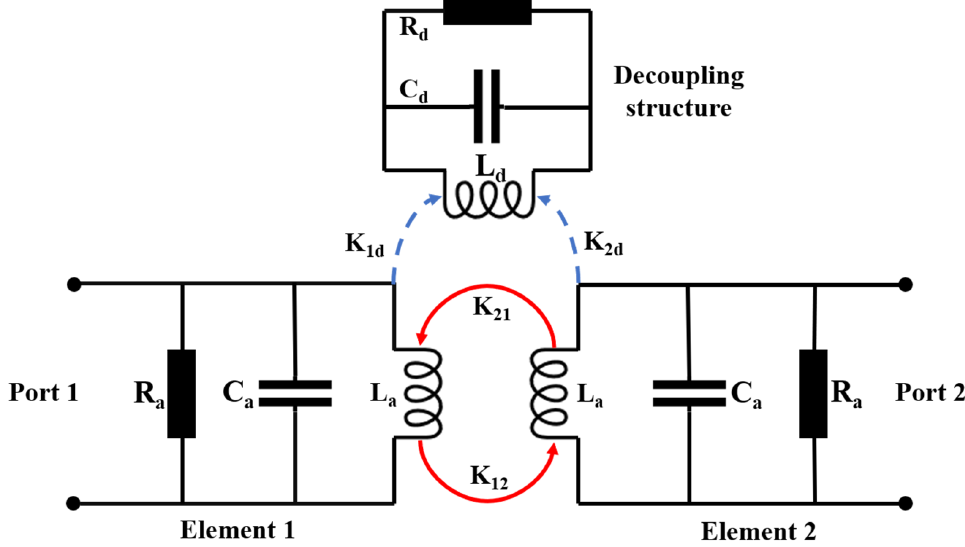
Figure 4. The equivalent circuit model of the proposed MIMO antenna.